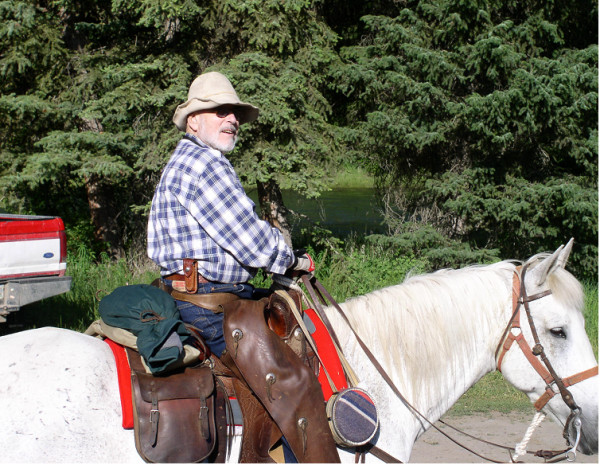
Dr. Joseph Levinson.